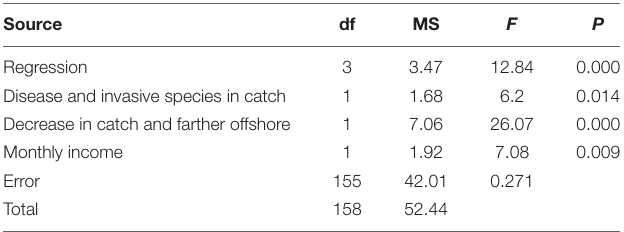
TABLE 6 | Results of the regression between the dependent variable (cpue) and various predictor variables.